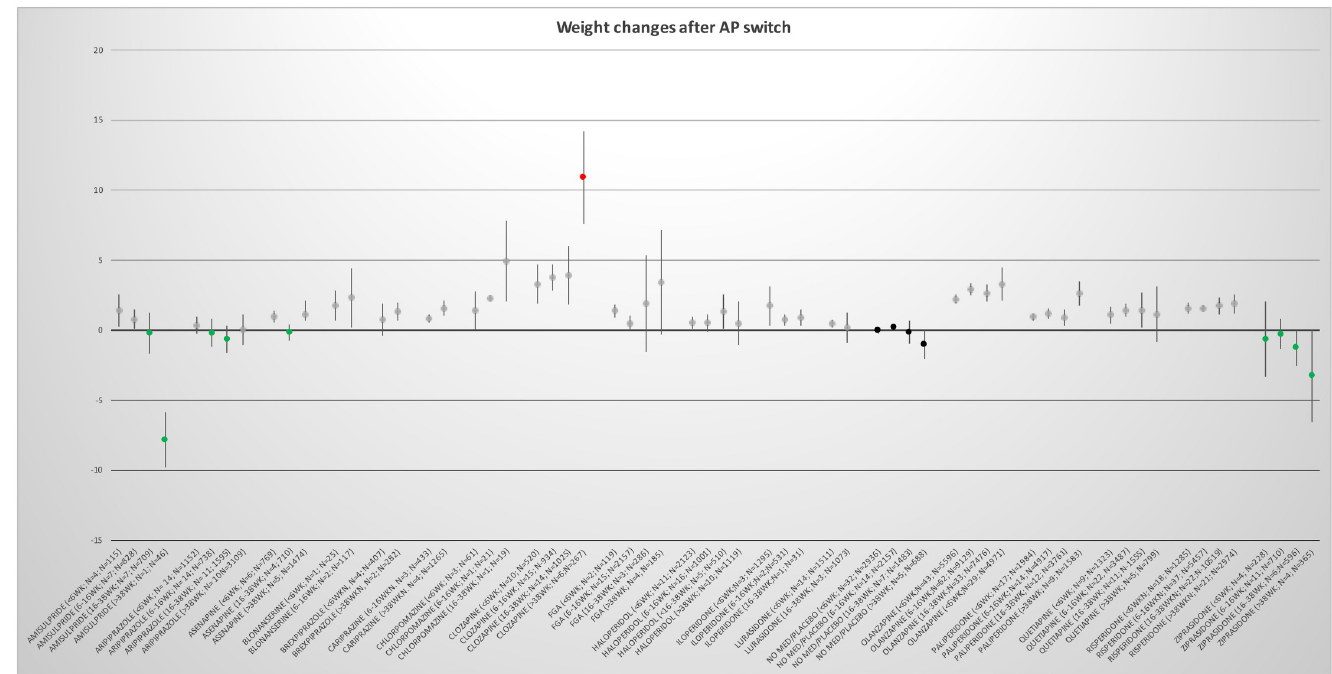
Fig 3. Mean change in body weight per AP per period of the AP-switch group. The antipsychotics per period. Green indicates almost no weight gain or weight loss. Grey indicates weight increase between 0 and 10 kg and red indicates weight increase > 10 kilograms per period. Black indicates placebo. After the antipsychotic between brackets is indicated period in weeks, number of studies (N) and number of patients